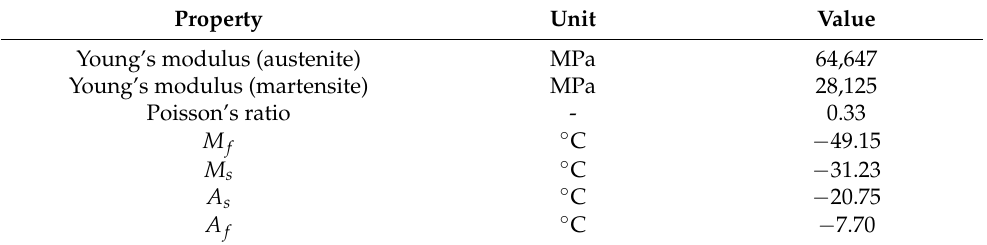
Table 3. Mechanical properties of Ni–Ti memory alloy presented by Pereiro-Barceló and Bonet [43].